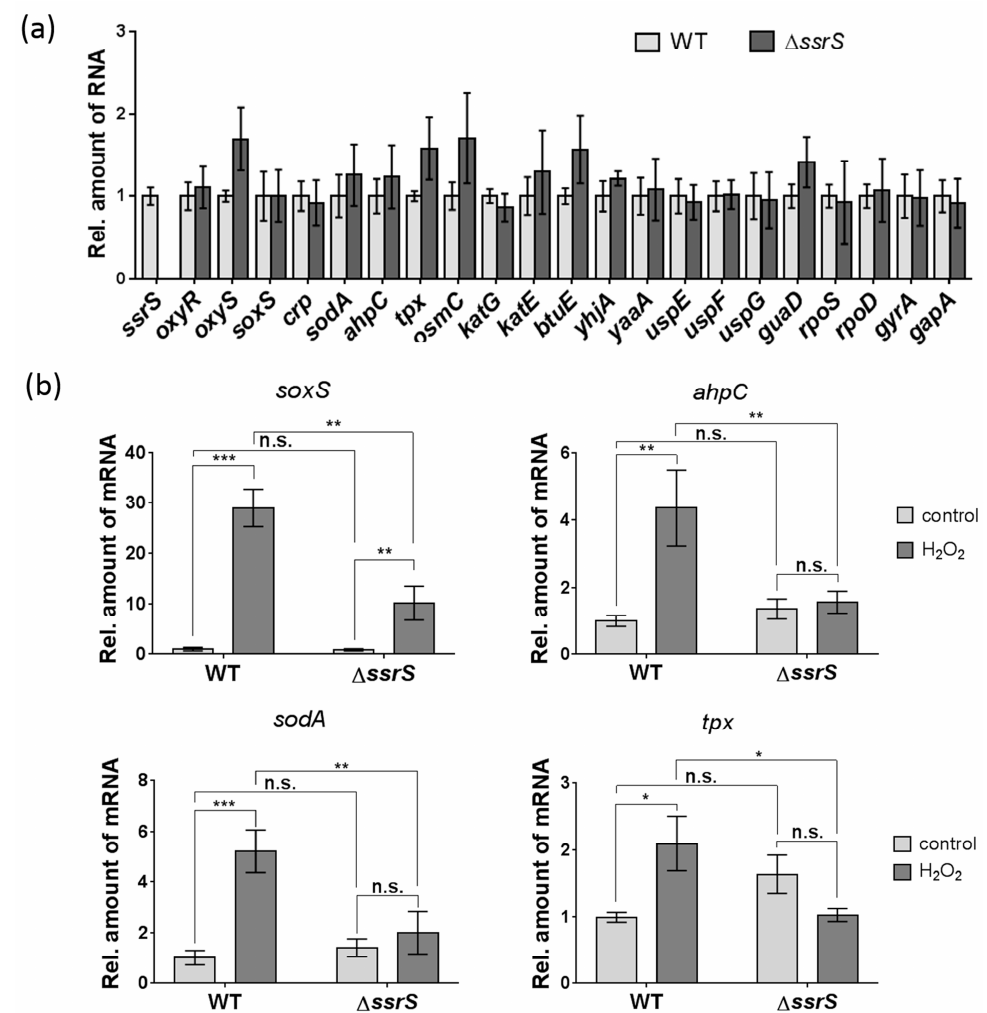
Figure 6. Relative expression levels (qRT-PCR) of selected mRNAs and non-coding RNA OxyS in E. coli WT and ∆ ssrS bacteria. ( a ) Standard conditions (in the absence of H 2 O 2 ). No significant changes in expression levels were detected for any of the analyzed genes (standard t-test). ( b ) Genes with dysregulated mRNA levels in ∆ ssrS bacteria under H 2 O 2 stress. Total RNA samples were isolated either before (control, light grey bars) or 10 min after treatment with 20 mM H 2 O 2 (dark grey bars). Statistical analysis was performed by the two-way ANOVA test, p -values: ***—<0.001; **—<0.01; *—<0.05; n.s.—not significant. Relative amounts of mRNAs were normalized to 16S rRNA and mRNA levels of the WT strain in the absence of H 2 O 2 were set to